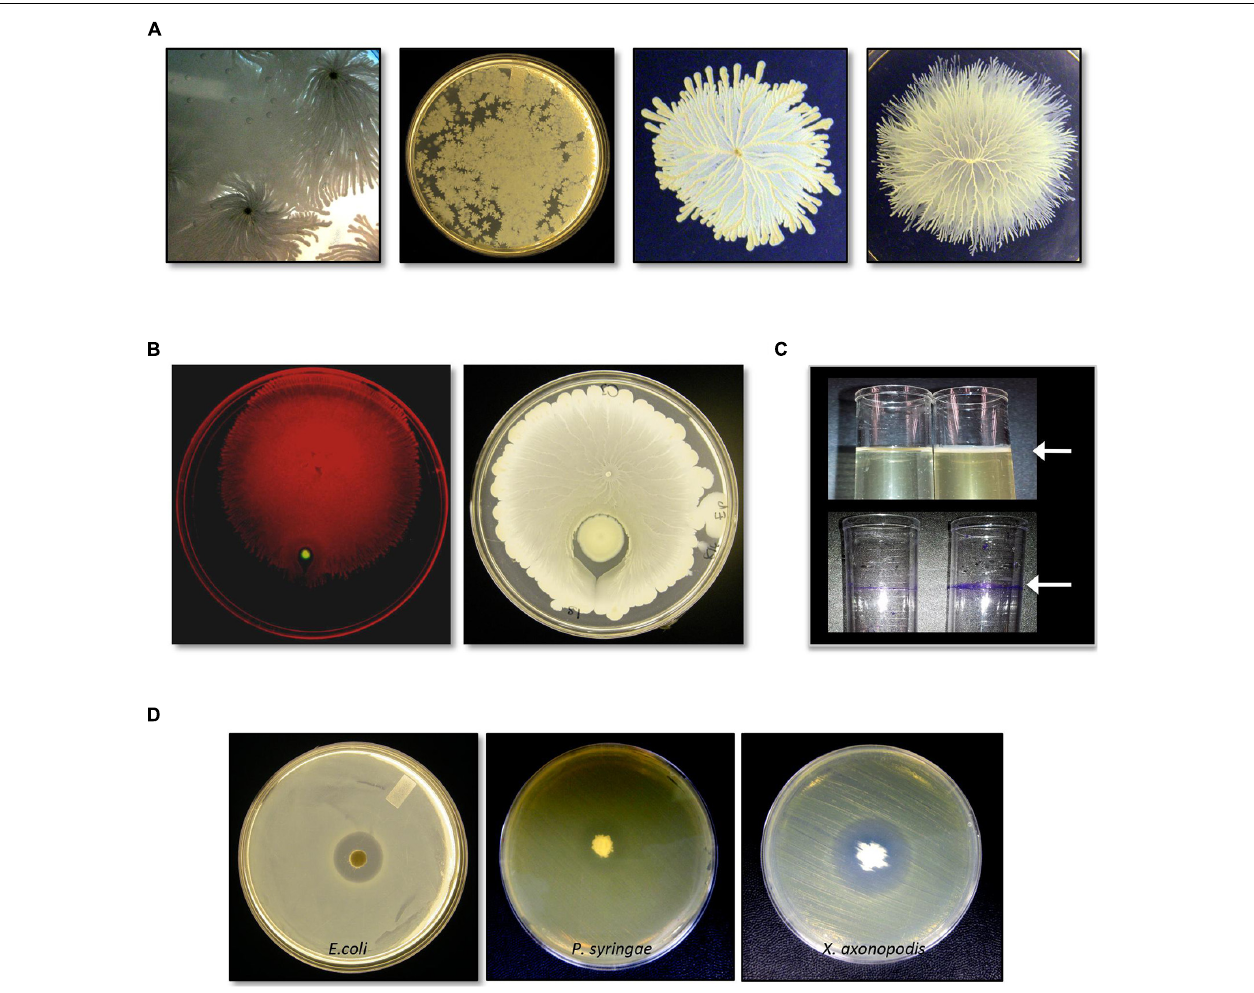
FIGURE 1 | Identification and characterization of bacterial isolate Bacillus safensis C3 isolated from Vigna radiata seeds. (A) Growth and swarm motility behavior of C3. (B) C3 surrounds P. aeruginosa when inoculated as a co-culture on swarm agar plates. (C) When grown in culture broth, C3 forms a pellicle visible as a thin layer on top of the growing culture (top panel, arrow). Pellicles are visible following staining with crystal violet. (D) C3 extract displays antimicrobial activity against Escherichia coli , Pseudomonas syringae, and Xanthomonas axonopodis when grown in TH and nutrient agar